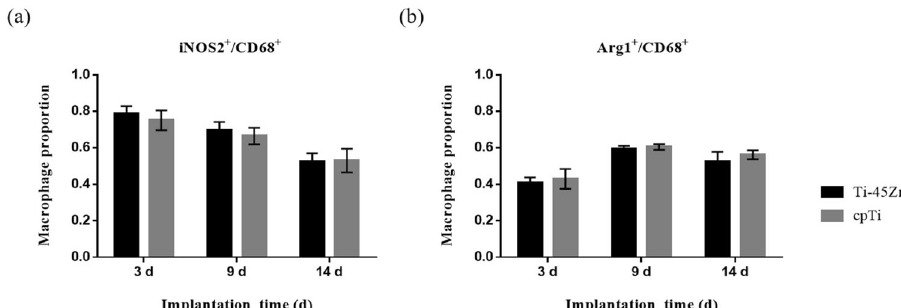
Fig. 10 a The proportion iNOS2 + cells and CD68 + cells at 3, 9, and 14 days after implantation; b The proportion Arg1 + cells and CD68 + cells at 3, 9,